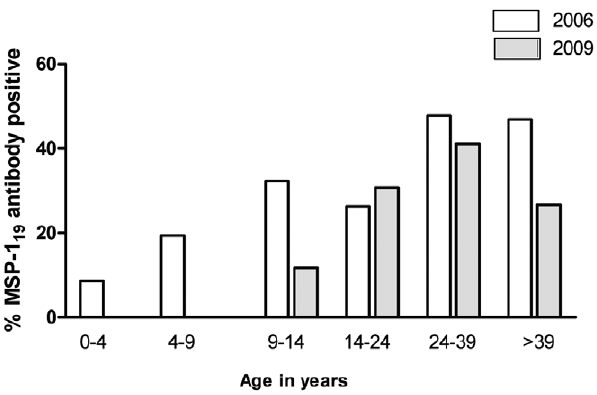
specific to each site (yellow lines) as well as the average across all sites (red line) for comparison. (B) Average annual % declines (with 95% confidence intervals) at each of the 10 sites under a linear model. Statistical analyses are given in Table 1.